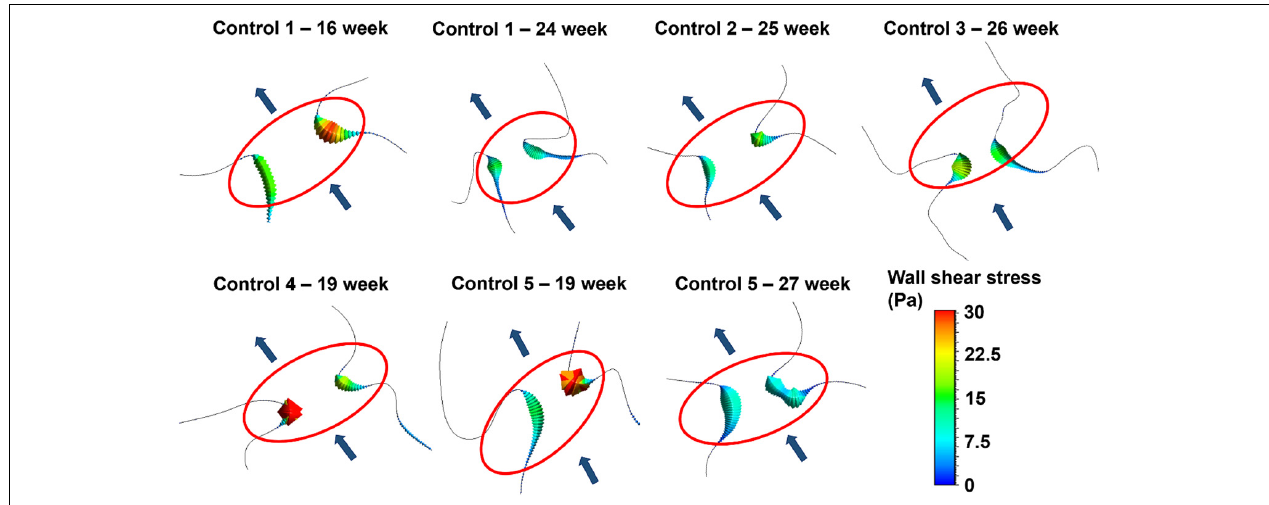
FIGURE 13 | Peak WSS levels on the two sides of the mitral valve at different gestational stages. The flow direction is shown by the arrows. The proximity of the mitral valve is shown inside the red